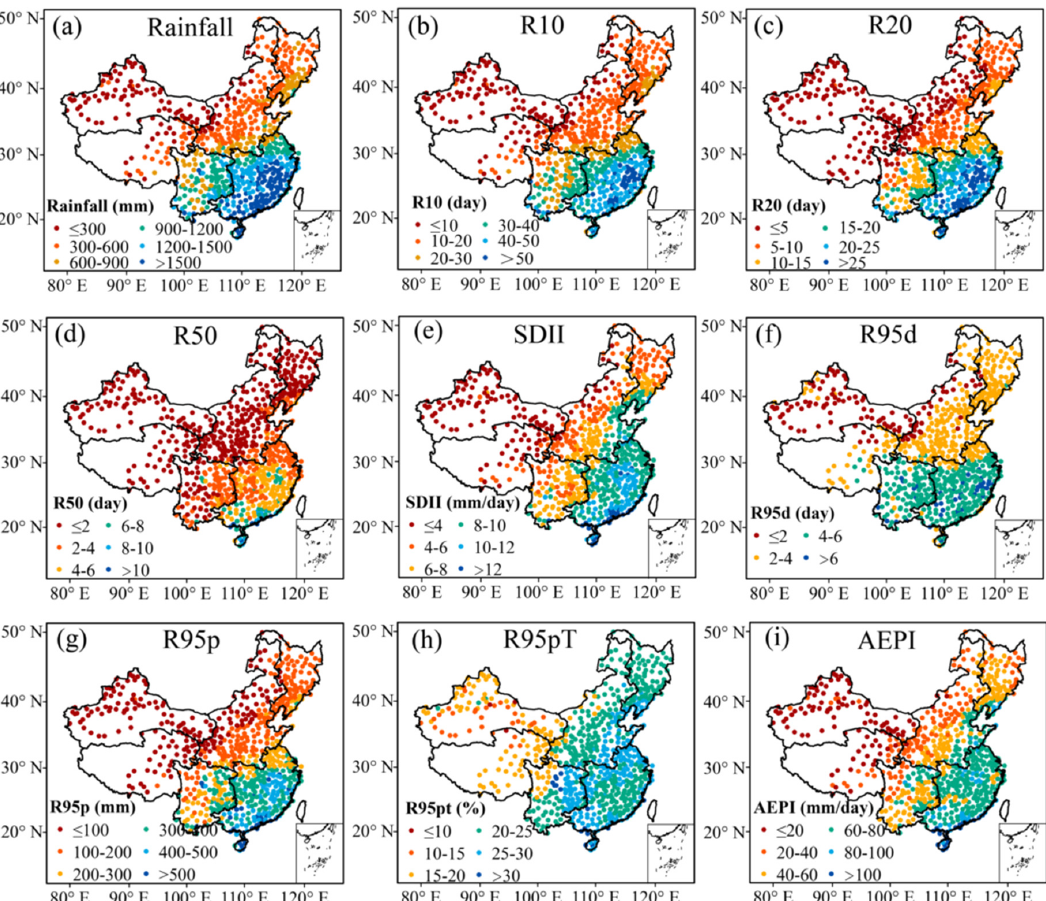
Figure 2. Spatial distribution of the average annual rainfall and EPIs from 1960 to 2017: ( a ) annual average rainfall, ( b ) annual average R10, ( c ) annual average R20, ( d ) annual average R50, ( e ) annual average SDII, ( f ) annual average R95d, ( g ) annual average R95p, ( h ) annual average R95pT, and ( i ) annual average AEPI.